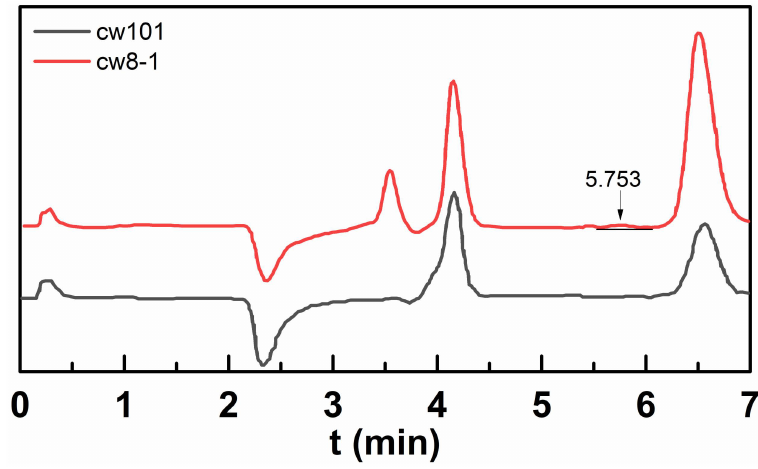
Figure 3. The IC spectra of cw101 and cw8-1 polymers emulsions.